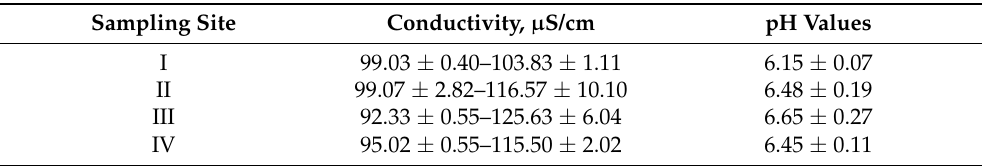
Table 1. Conductivity and pH values of soil (n = 3, average mean ± SD, four different sampling sites, I–IV) of Solidago spp. growing locality.